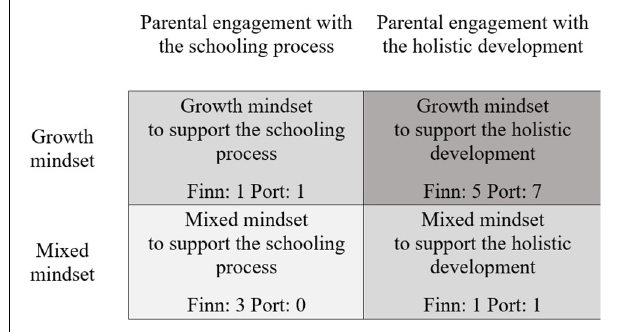
FIGURE 1 | Parental engagement–mindset